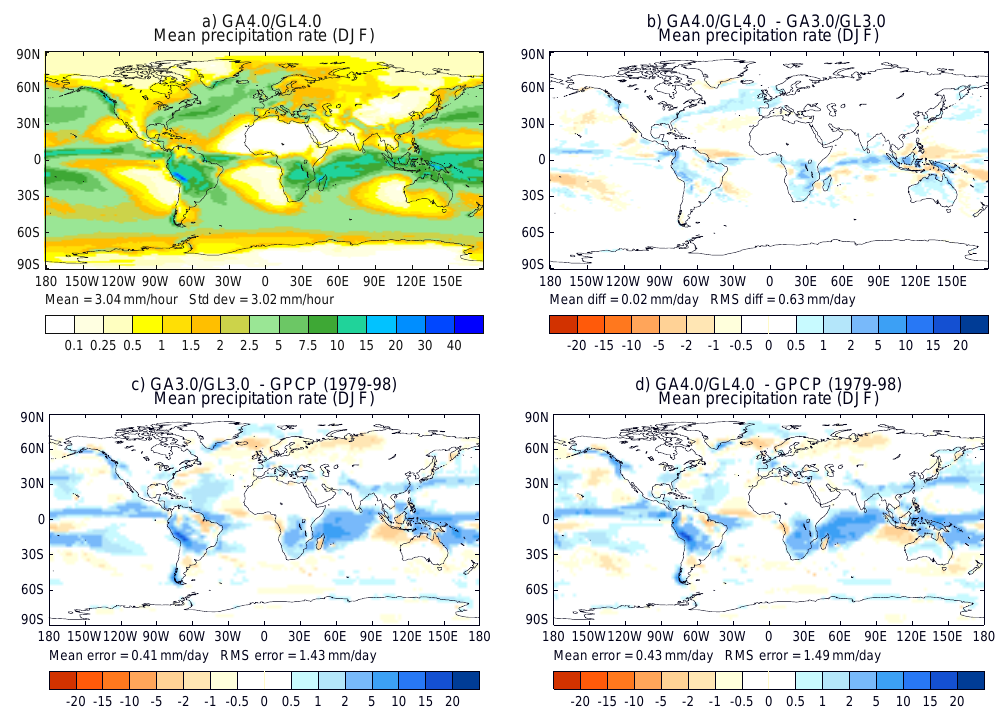
Fig. 8. Climatological mean precipitation rate during DJF from N96-AL_clim using the same format as Fig. 7. The validating data set is the GPCP climatology (Adler et al., 2003).